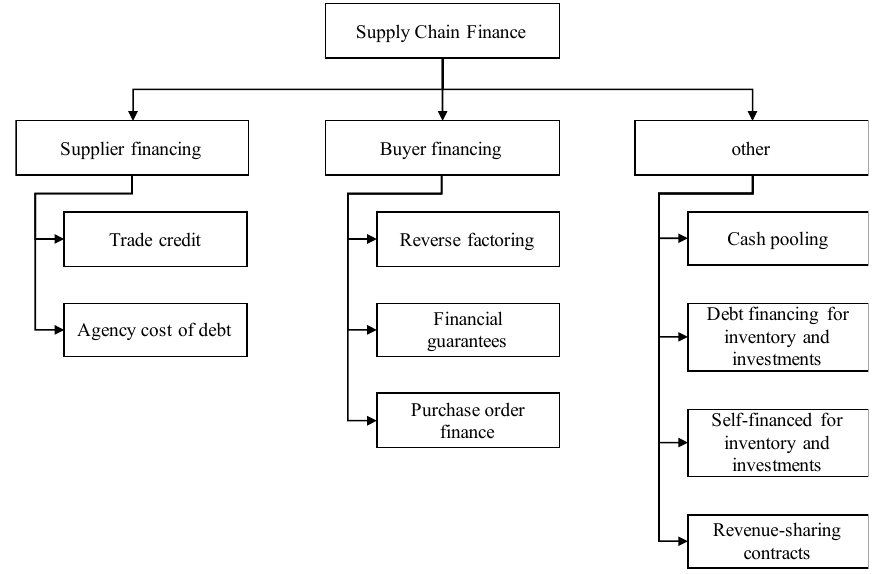
Figure 1. Supply chain finance solutions.